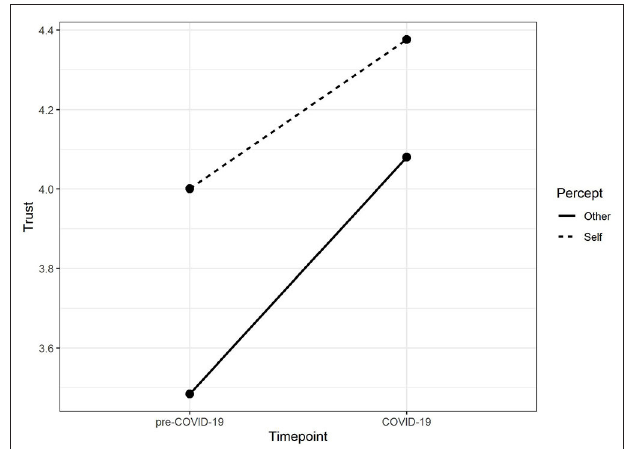
FIGURE 1 | Change in perception of trust in medical services before and during COVID-19. Individuals perceived that their trust increased as well as that of others, and improvement of others was even greater during